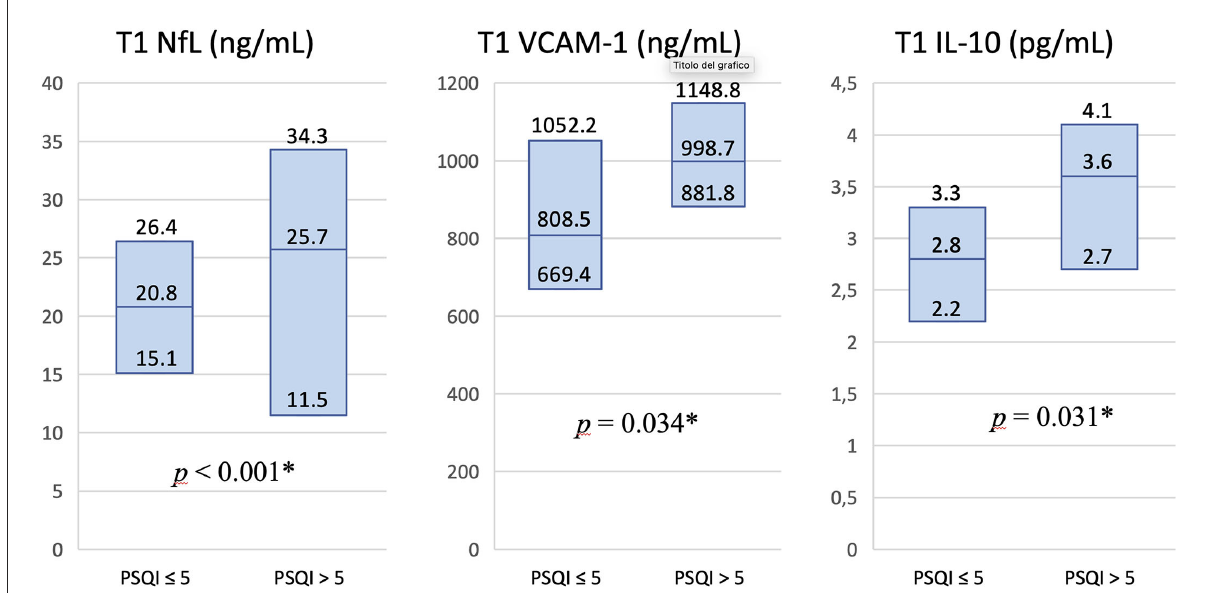
FIGURE3 Differences in levels of blood biomarkers in patients with normal vs. abnormal PSQI total score at T1 study visit. Serum T1 levels of NfL, VCAM-1, and IL-10 were significantly higher in patients classified as poor sleepers at T1 evaluation. Values in columns are expressed as median and interquartile range. PSQI, Pittsburgh Sleep Quality Index; NfL, neurofilament light chain; VCAM-1, vascular cell adhesion molecule 1; IL-10, interleukin 10; T1, 2-month study visit; * p <